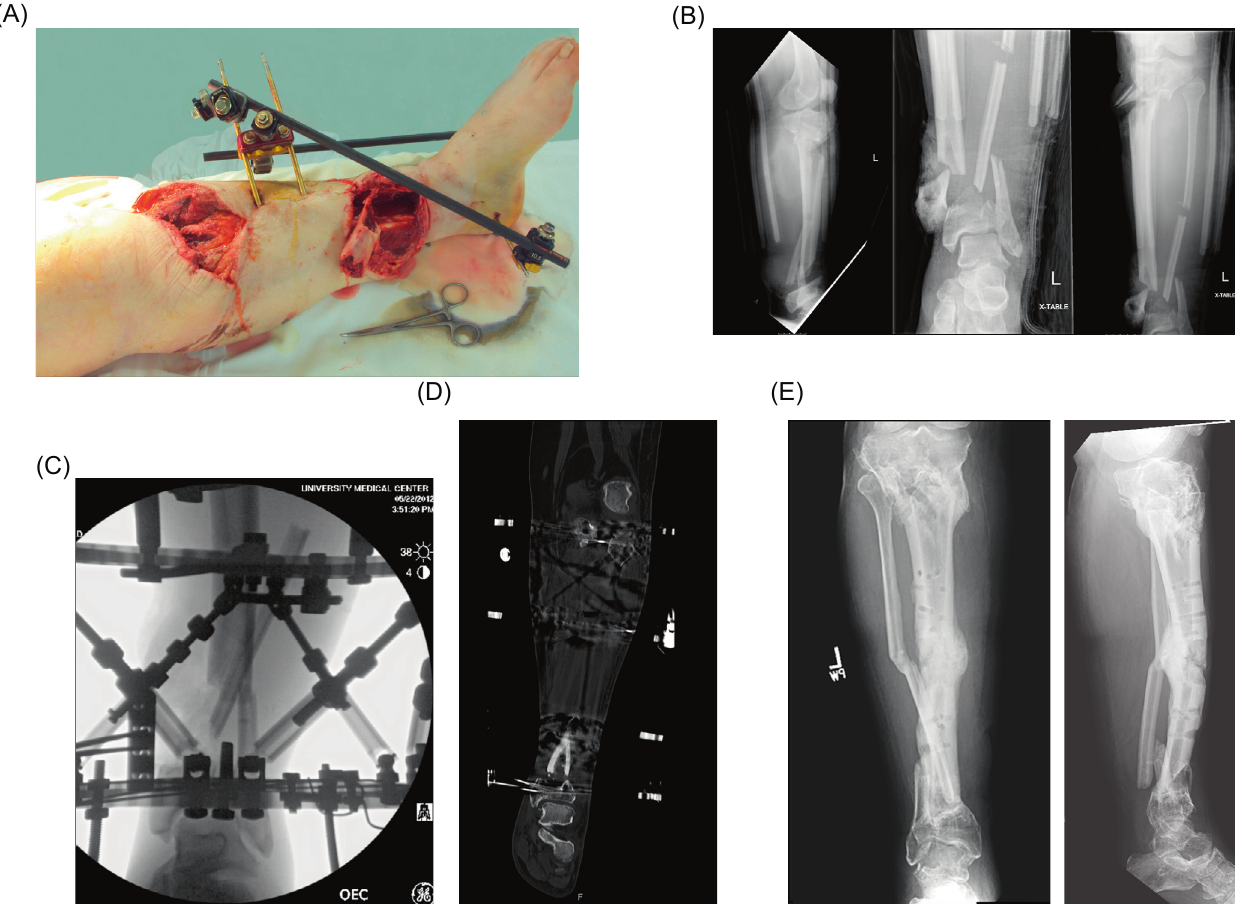
Figure 1. Case example of a 49-year-old male polytrauma who sustained a Gustilo-Anderson grade IIIB open left proximal and distal tibial fractures following airplane crash. (A) Clinical images of large anteromedial wounds over the proximal and distal thirds of the leg with segmental bone loss distally, (B) anteroposterior and lateral injury radiographs demonstrating the aforementioned injuries with associated fibular fracture, (C) initial post-operative fluoroscopic images with Taylor Spatial Frame (TSF) in place, (D) coronal CT renderings of the distal tibial fracture at the time of nonunion (seven months following injury) with Taylor Spatial Frame in place, and (E) final film taken one year following RIA at the time of union and TSF